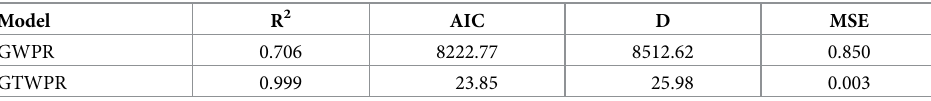
Table 6. The comparison of models (6) and (7).